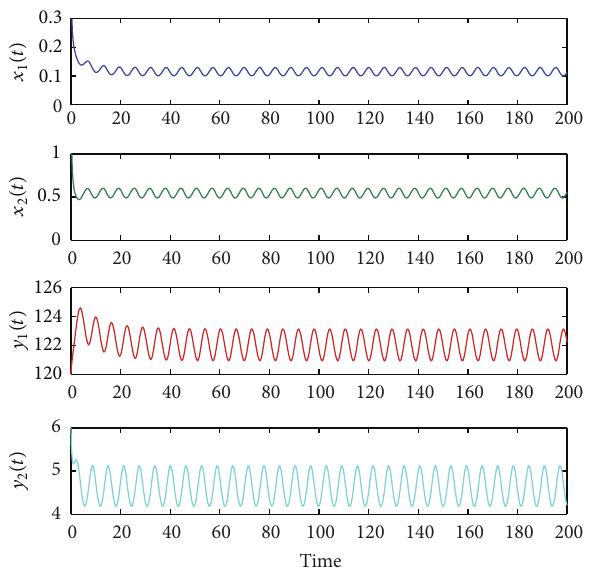
Figure 1: Dynamical responses of the unique positive 2𝜋 -periodic globally stable solution of model system (4).